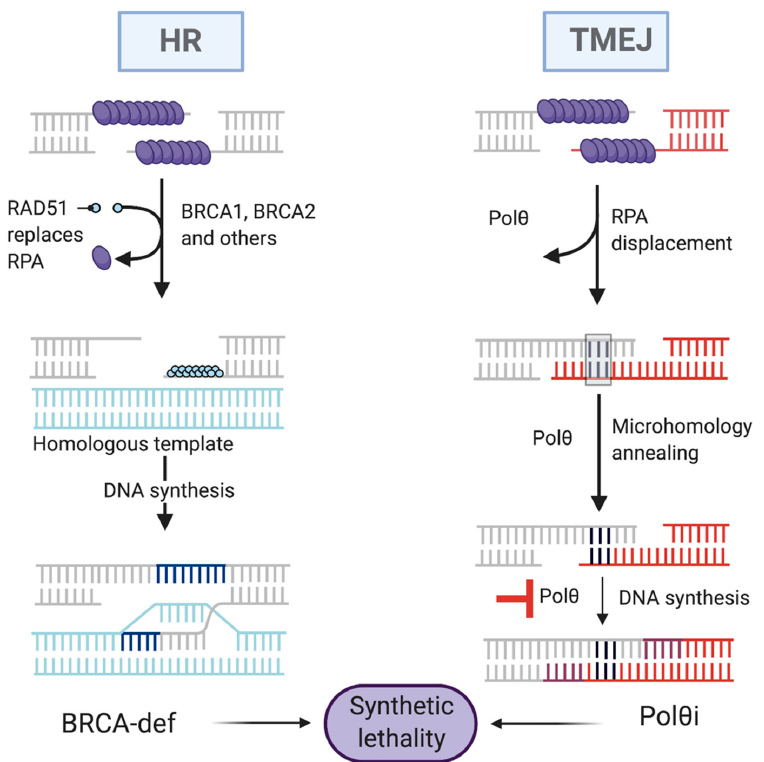
Figure 2. The synthetic lethality (SL) strategy in homologous recombination (HR) deficient